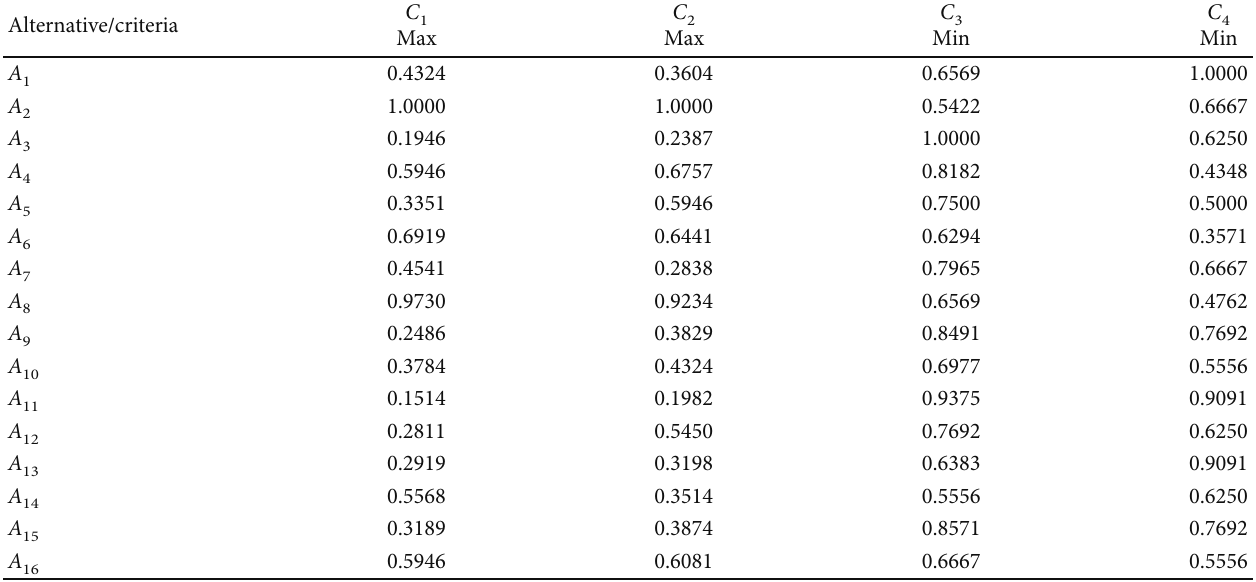
Table 2: Normalized decision-making matrix.